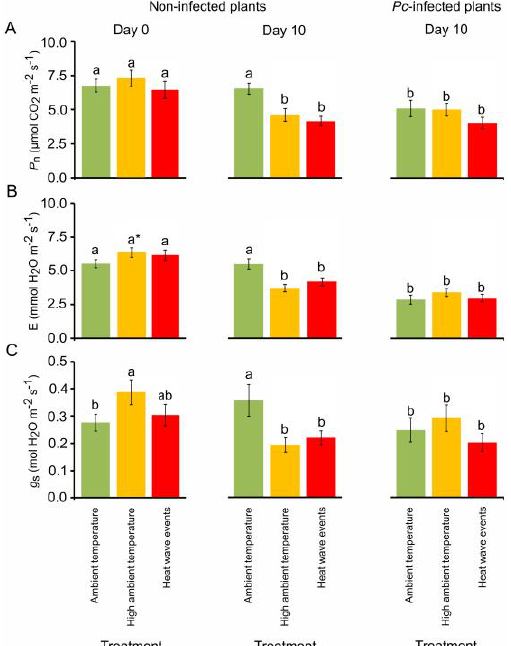
Figure 2. Photosynthetic rate values ( P n ) ( A ), transpiration rates ( E ) ( B ) and stomatal conductance ( g s ) ( C ) of Castanea sativa seedlings exposed to ambient temperature (green), high ambient temperature (orange) and two heat waves (red). Measurements were obtained 0 and 10 days after plants were exposed to treatments (non-infected plants) and 10 days after plants were exposed to treatments and Phytophthora cinnamomi ( Pc ) infection ( Pc -infected plants). Vertical bars are standard errors, different letters indicate significant differences between means ( p < 0.05), and asterisks indicate marginally significant differences ( p < 0.10) (Tukey’s HSD